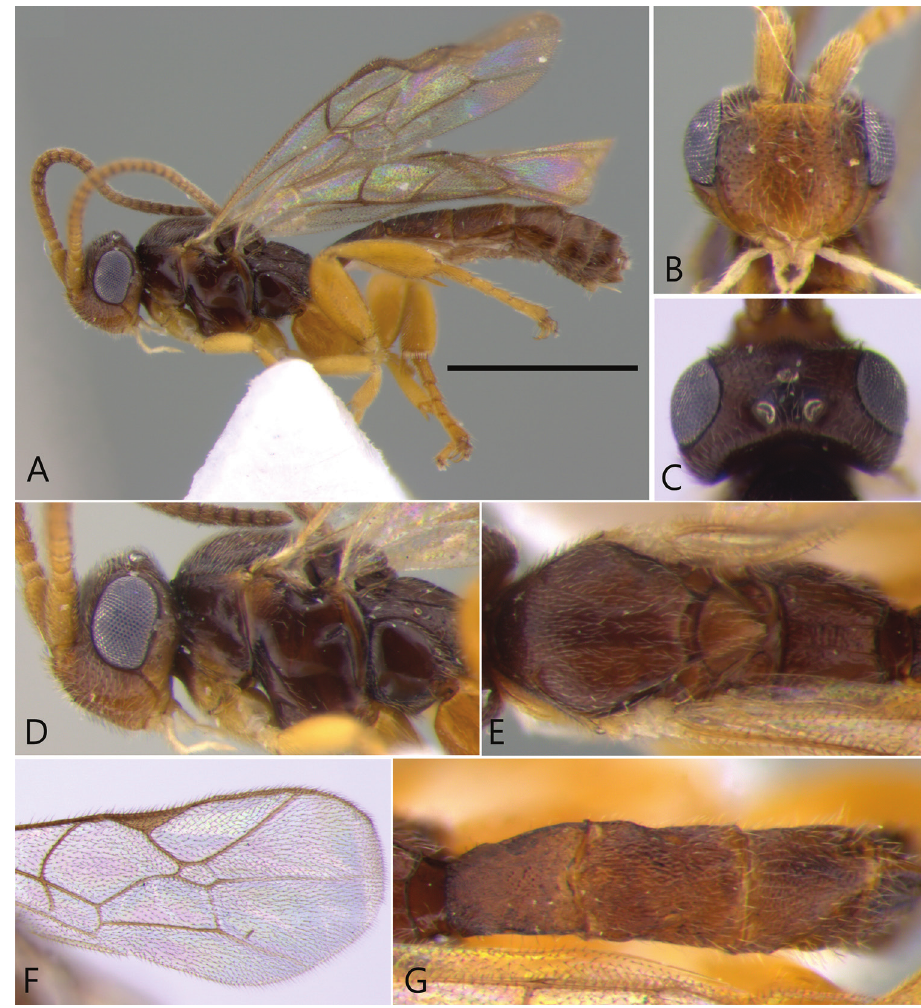
Figure 11. Orthocentrus pacificus sp. nov. Holotype. A Habitus in lateral view B head in frontal view C head in dorsal view D head and mesosoma in lateral view E mesosoma in dorsal view F areolet G first to third tergites in dorsal